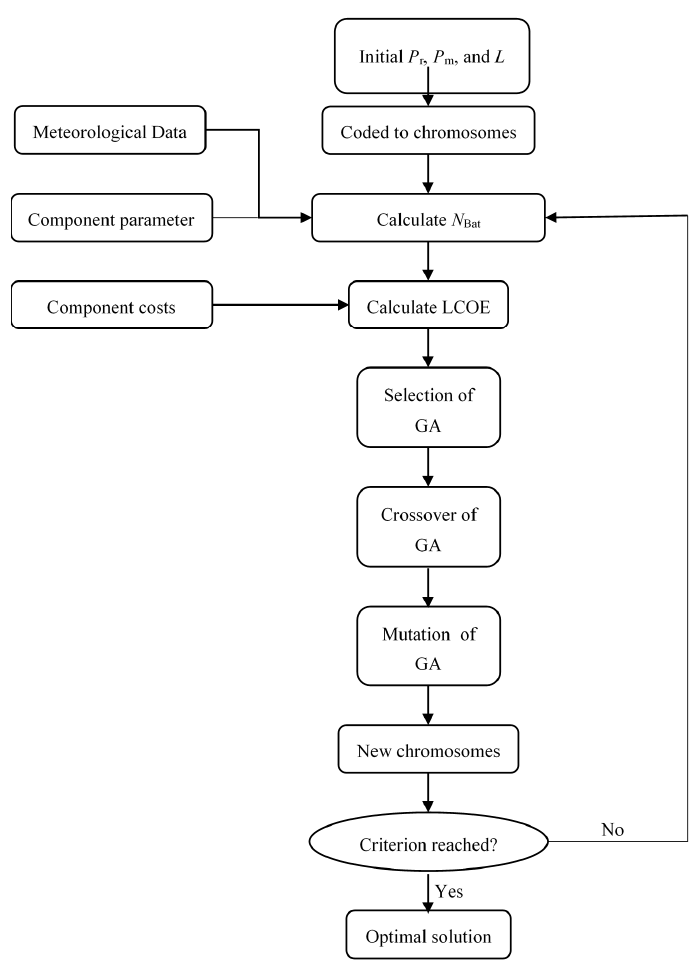
Figure 9. Flow chart of the model. LCOE: levelized cost of energy and GA: genetic algorithm.